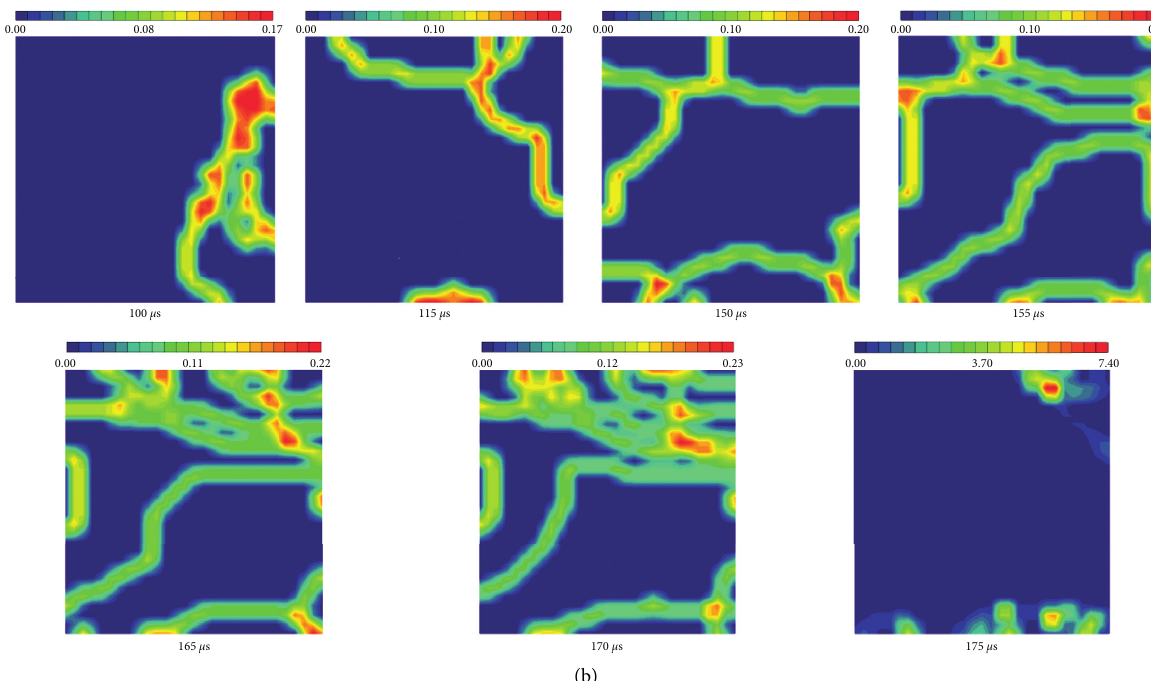
Figure 10: Maximum shear strain cloud diagram of layered composite rocks (9.8m/s). (a) B ⟶ W sample. (b) W ⟶ B